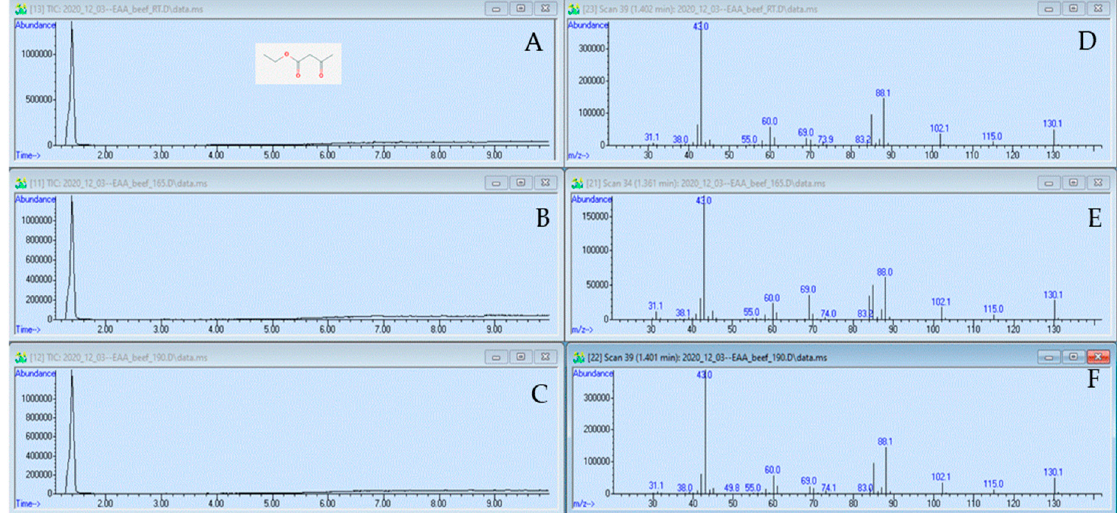
Antibiotics 2021 , 10 , x FOR PEER REVIEW 4 of 11